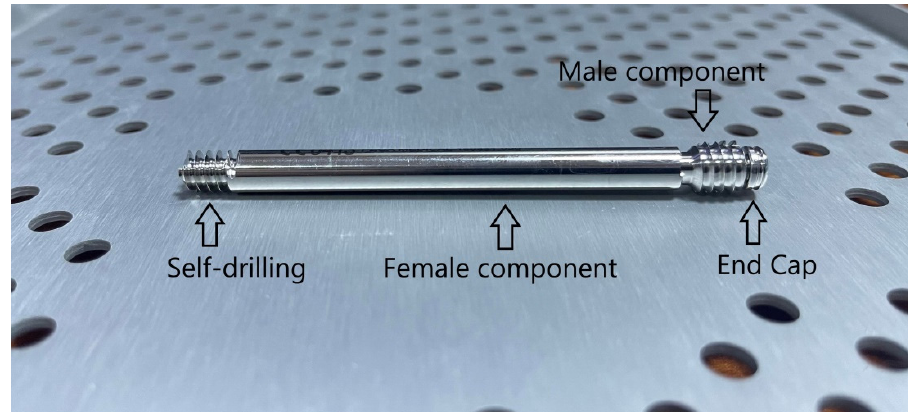
Figure 1. The Free-Gliding SCFE Screw System.